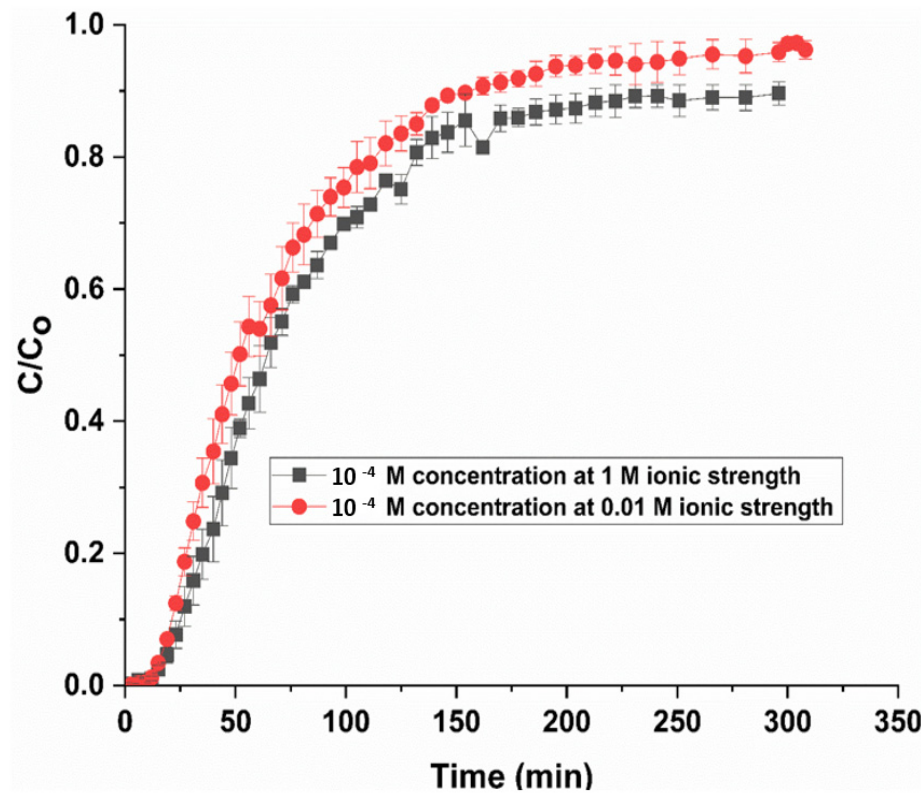
Figure 6. Selenite breakthrough curves for 10 − 4 M initial concentration at two ionic strengths values.